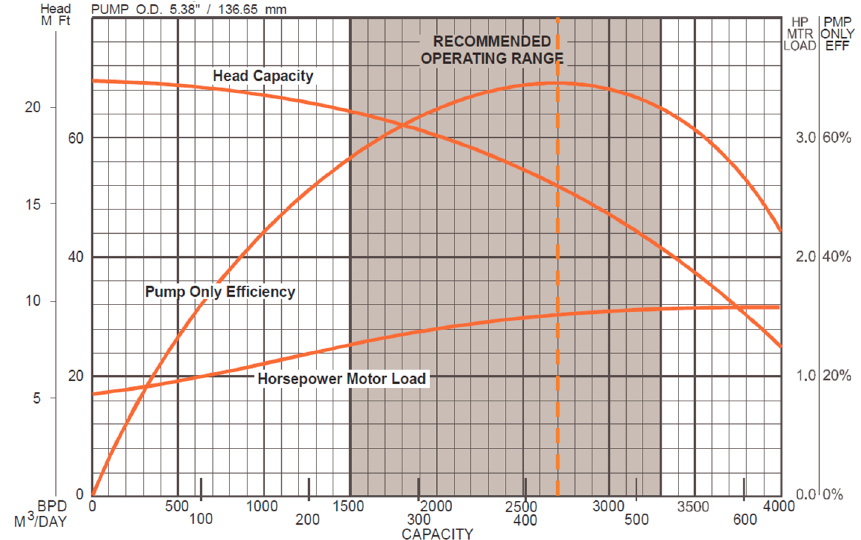
Figure 2. Typical ESP pump performance curves (figure courtesy of Wood Group ESP, Inc., Oklahoma City, OK, USA).